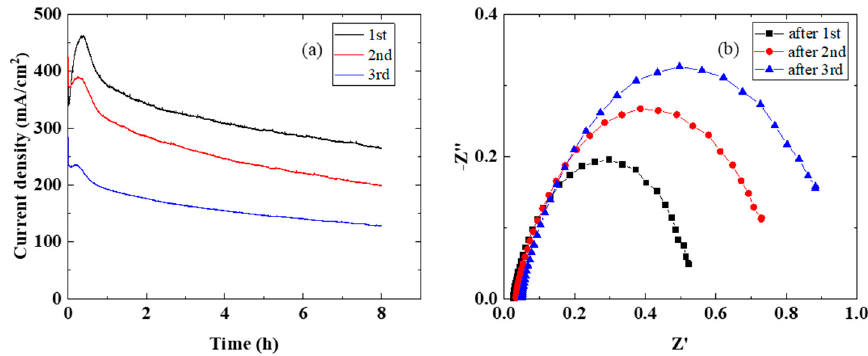
Figure 5. Time dependence of the single cell using sample 1 at 120 °C and 1.7 V: ( a ) current density vs. time and ( b ) EIS properties.